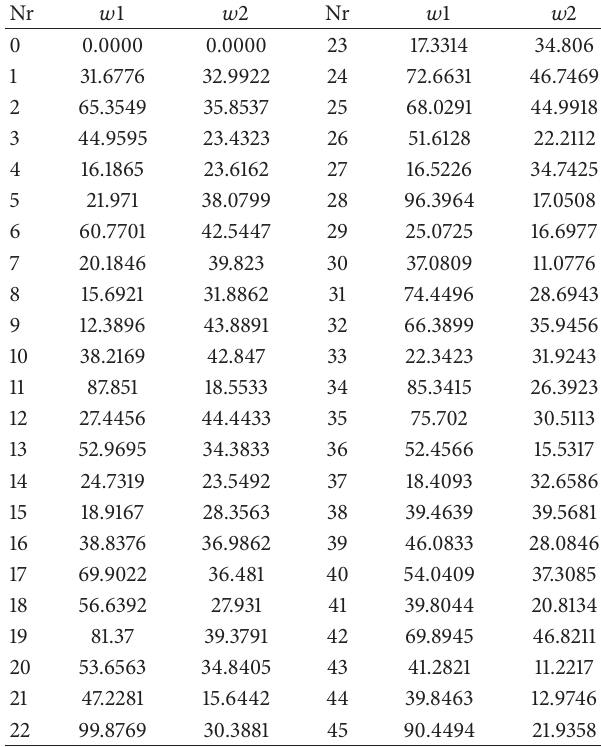
Table 5: Cost associated with each